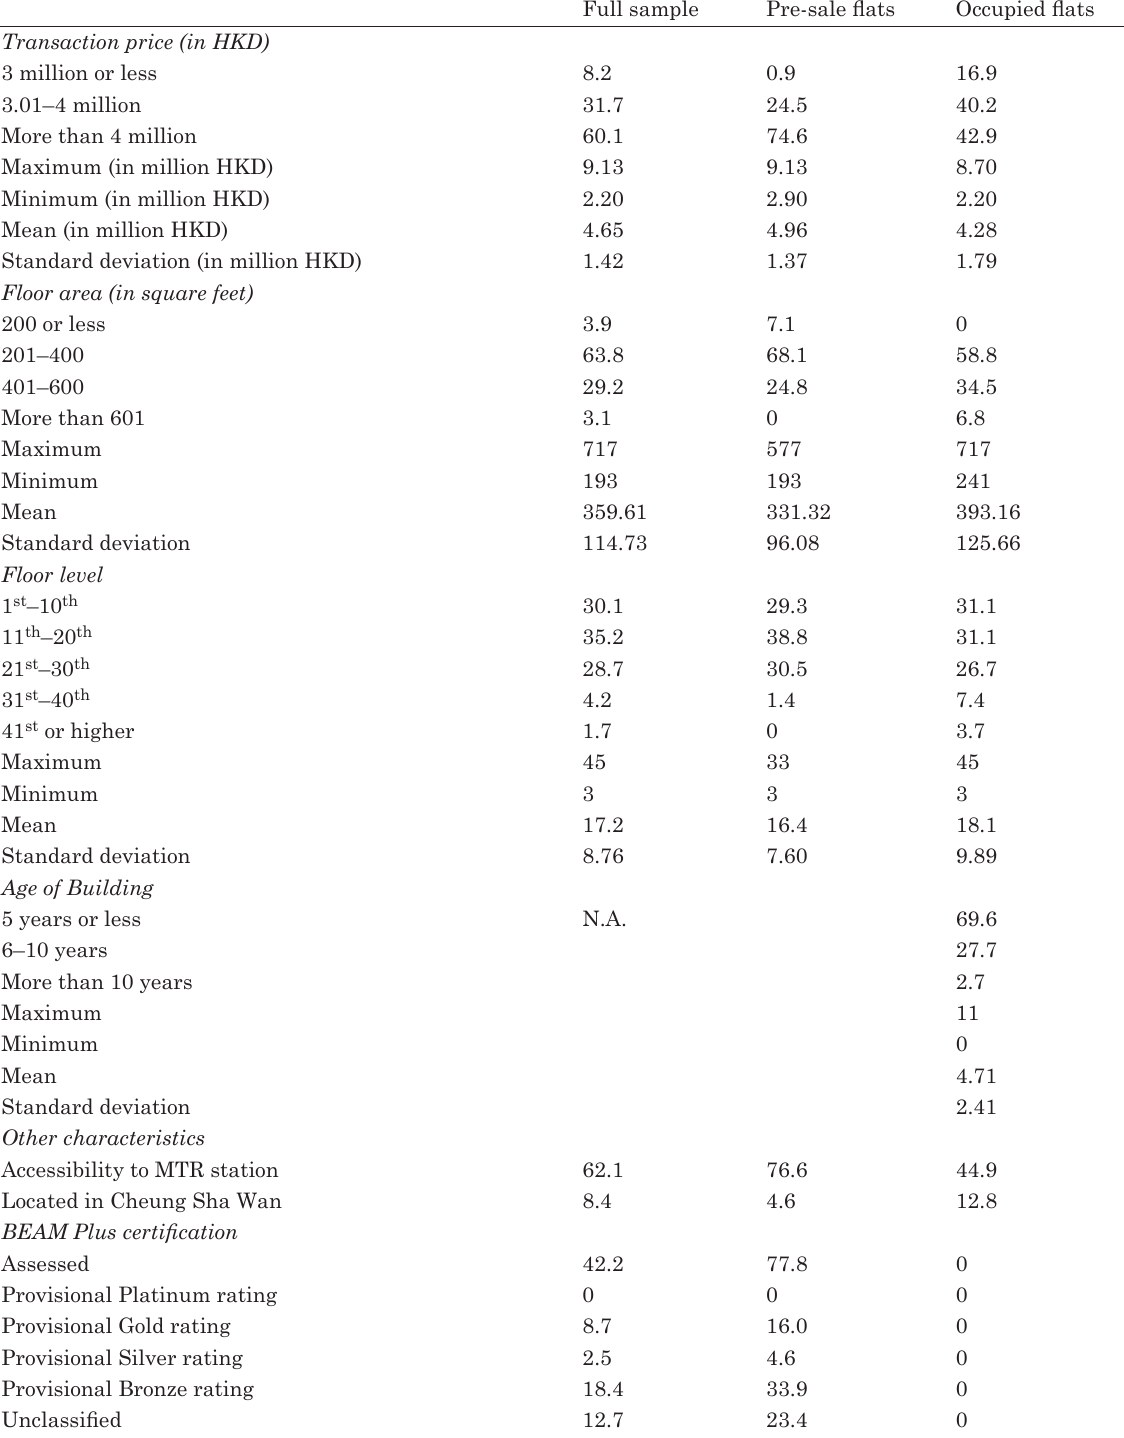
Table 5. Descriptive statistics of residential units in the